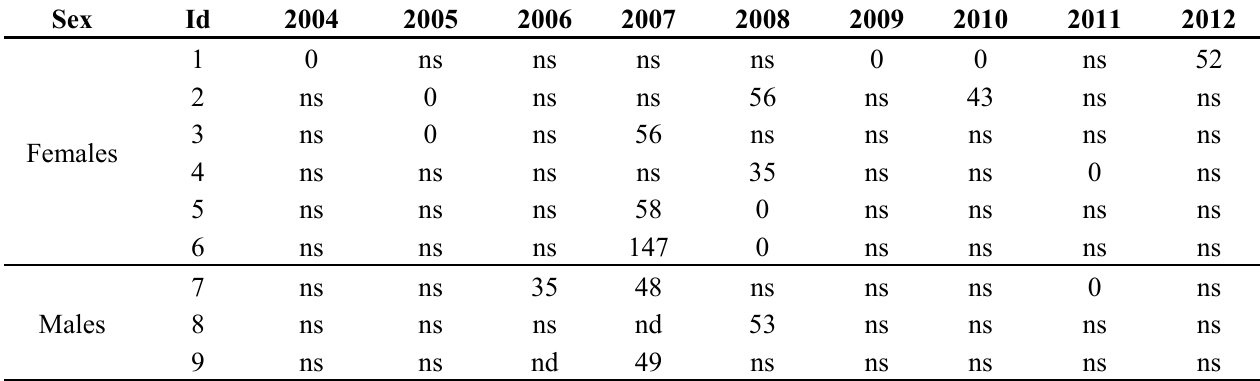
Table 2. Individual serological follow-up in captured-mark-recaptured P. austriacus